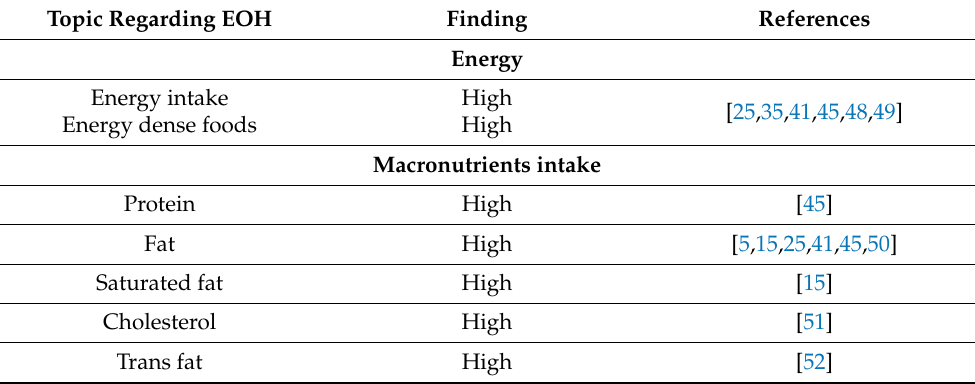
Table 3. Main findings linking eating out of home and nutritional